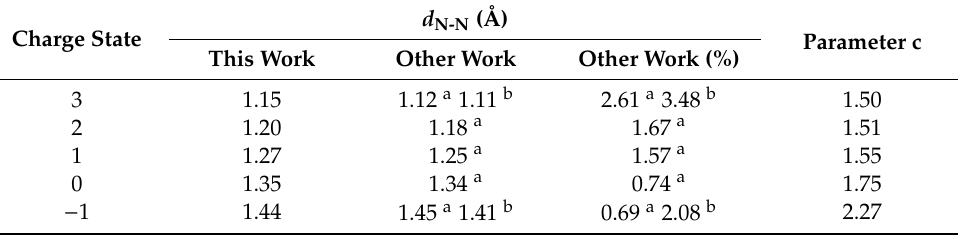
Table 1. Bond length and parameter c of different charge states of N i .